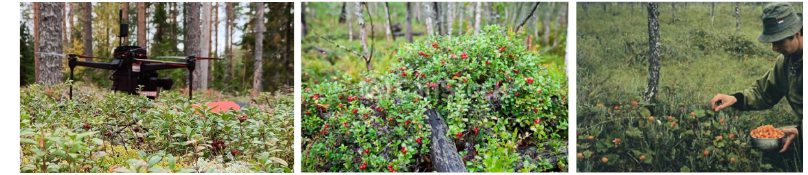
Figure 1. A view on the work field of the FEROX